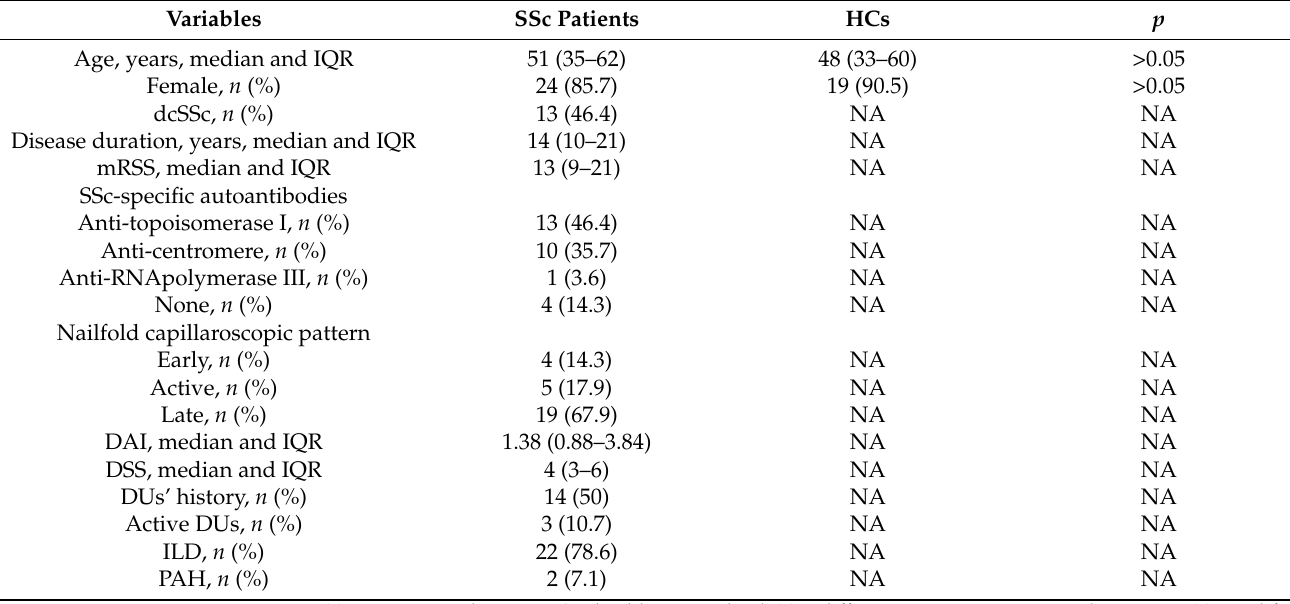
Table 1. Demographic and clinical features of 28 systemic sclerosis (SSc) patients and 21 healthy controls